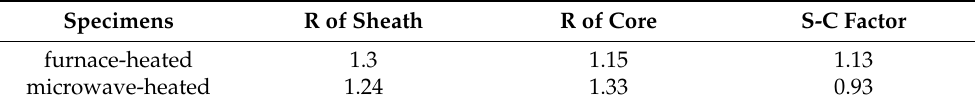
Table 3. The sheath-core factor of furnace-heated and microwave-heated